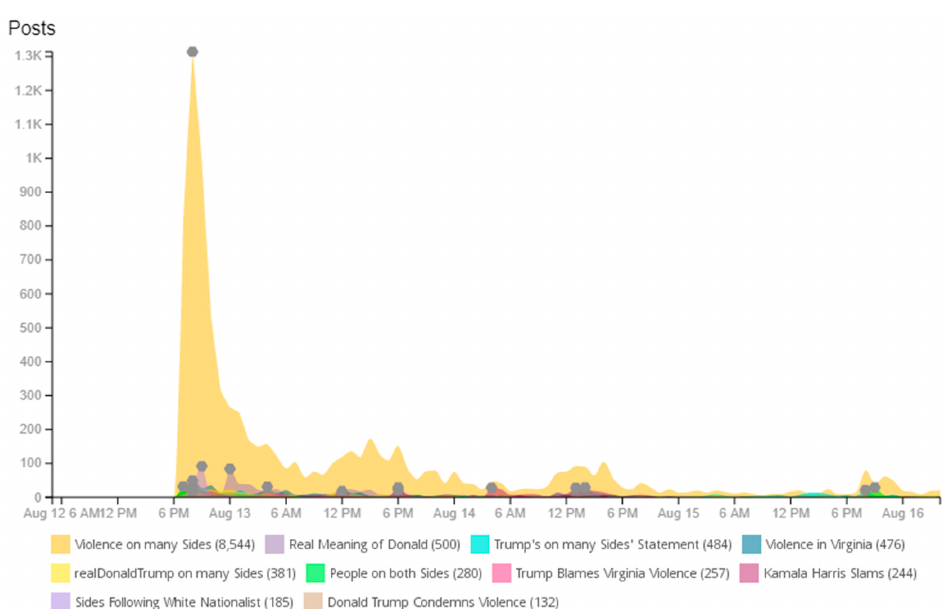
Figure 1. Topic waves following Trump’s Saturday statement. (Crimson Hexagon).